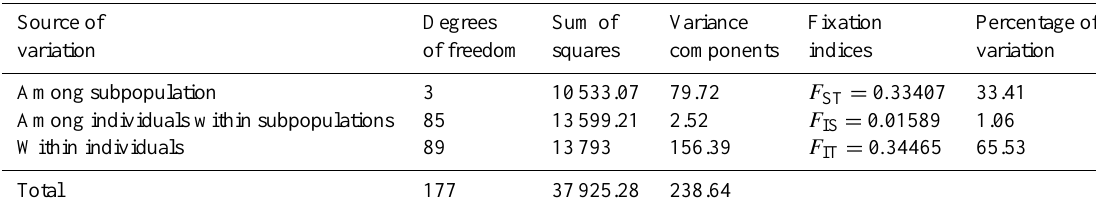
Table 3. Analysis of molecular variance (AMOVA) based on selected SNPs. Source of Degrees Sum of Variance Fixation Percentage of